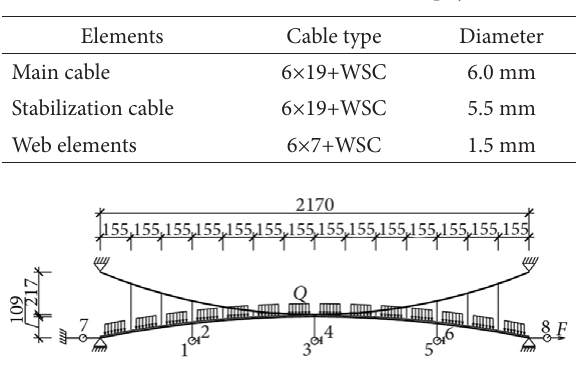
Fig. 4. Scheme of the suspension bridge physical models loading